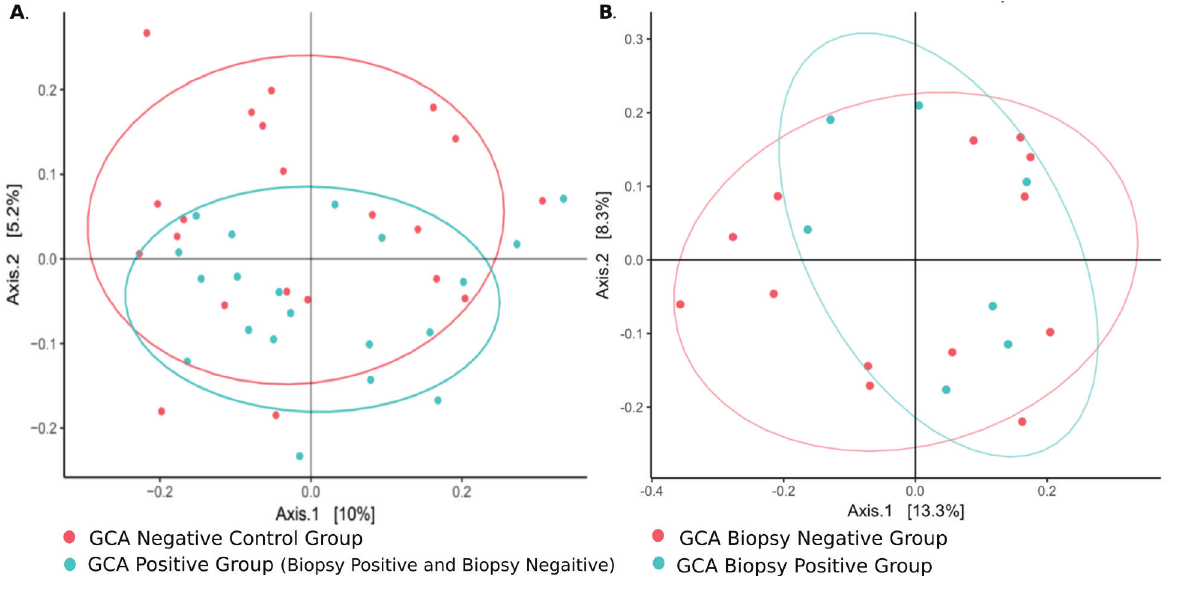
Figure 2. Microbiomes from TAs with biopsy-positive and biopsy-negative GCA cluster together but differently from those from control patients. Principal component analysis (PCoA) of TA microbiomes. (A) β-diversity (not α, data not shown), differs between GCA and control groups ( P = 0.042). (B) There were no statistically significant differences between TA microbiomes in those with biopsy-positive GCA vs those with biopsy-negative/clinically positive GCA ( P >